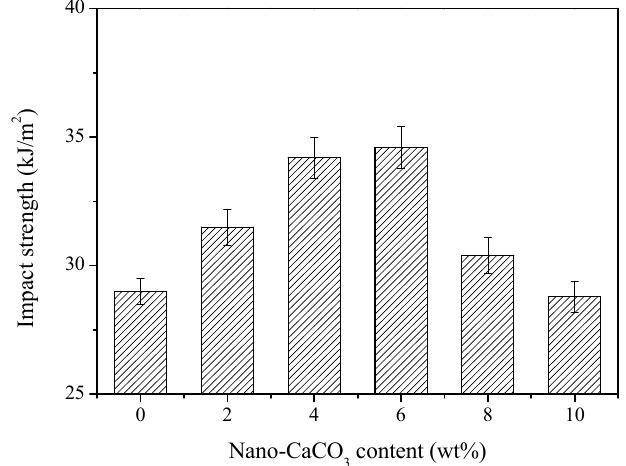
Figure 11. Impact strength of polypropylene (PP) foams as a function of nano-CaCO 3 content, reproduced from [18] under open access license.